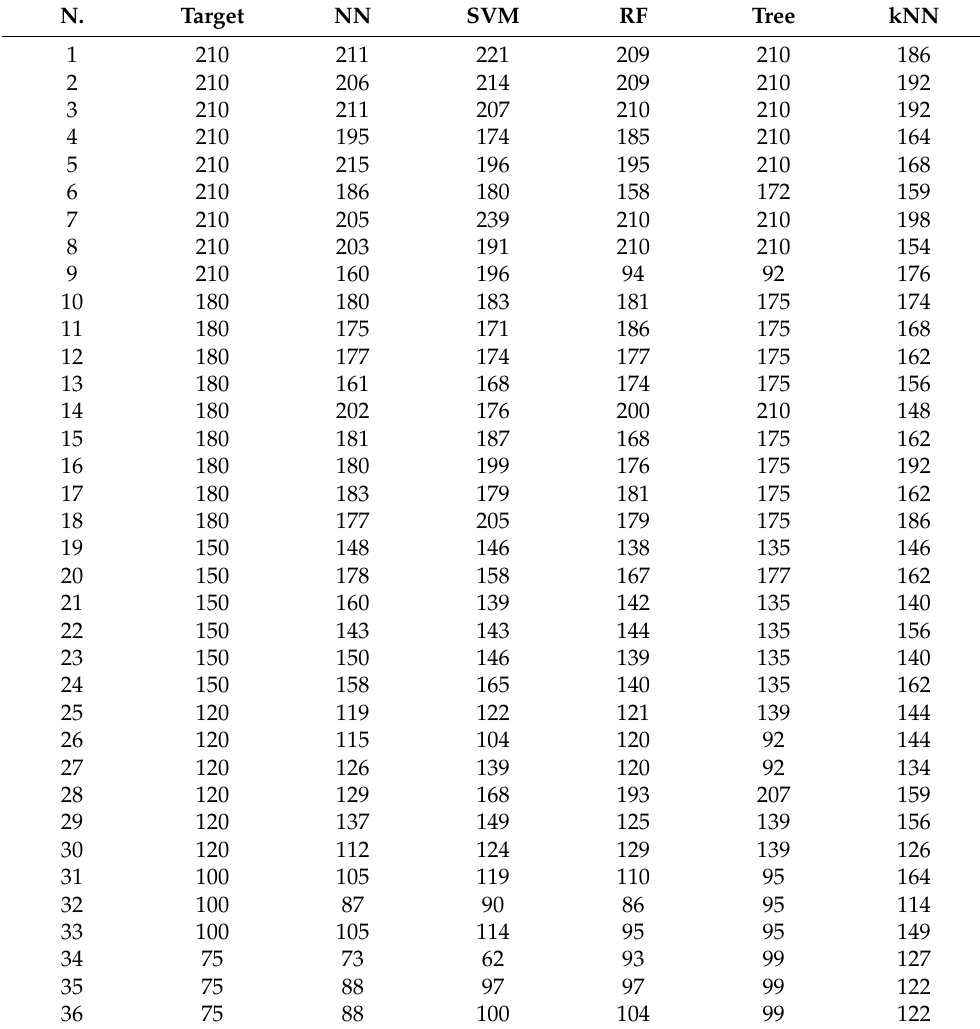
Table A2. Target and predicted values by the neural network (NN), support vector machine (SVM), random forest (RF), classification tree (Tree), k-nearest neighbors (kNN) learning algorithms.